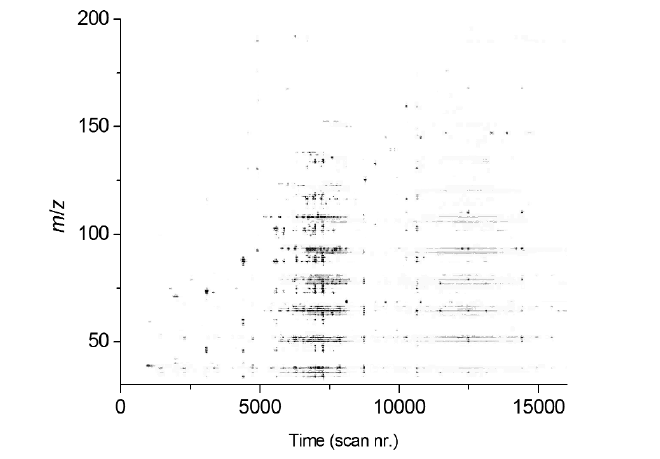
Figure 2. Three dimensional gas chromatography—mass spectrometry data display. Data were obtained in week nr. 6 before damage of tomato plants. Light grey colours represent low intensities of the corresponding m/z values while dark grey colours represent high intensities of the corresponding m/z values. ( m/z = mass-to-charge